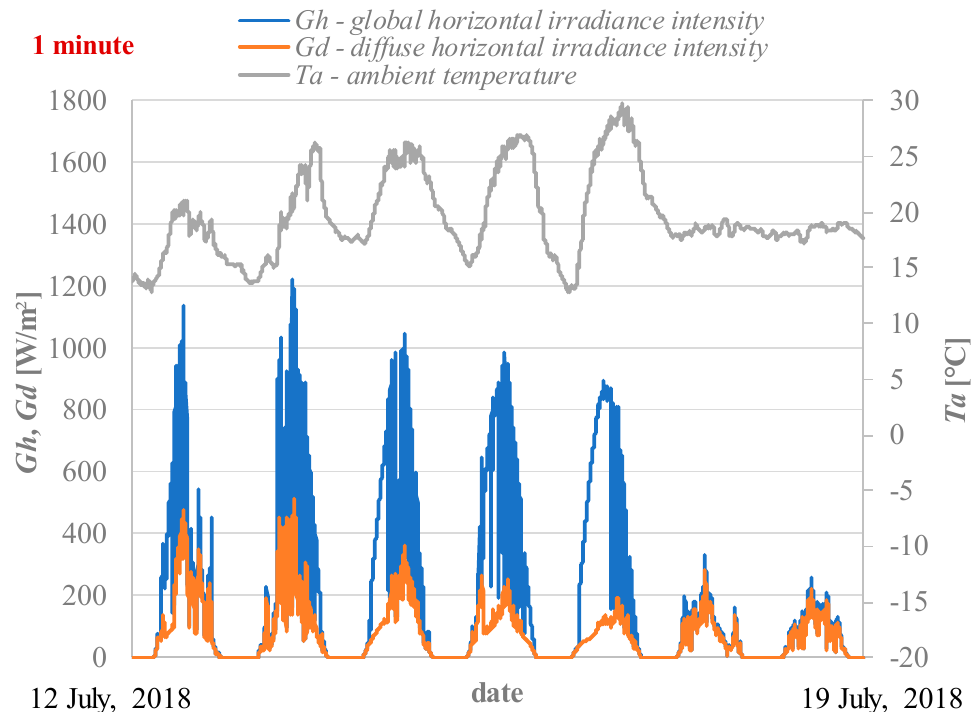
Figure 4. Weather conditions during the selected week of observation using a 1 min aggregation interval.